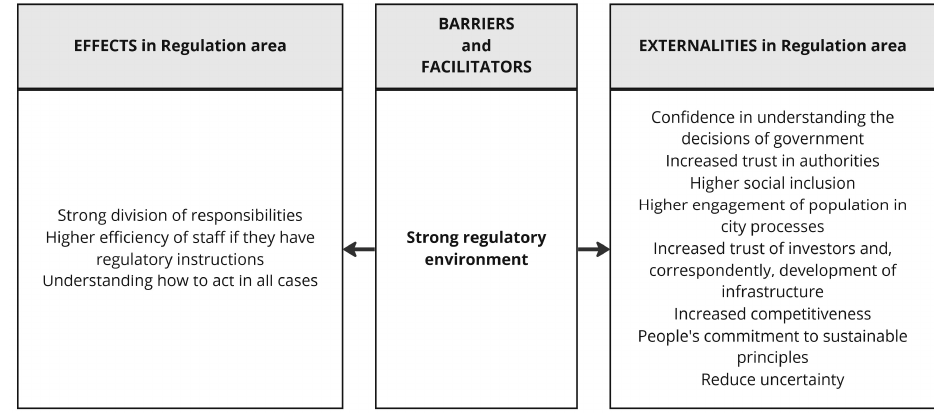
Figure 8. Barriers or facilitators, effects, and externalities of smart governance implementation in Regulation area. Source: generated by the authors.